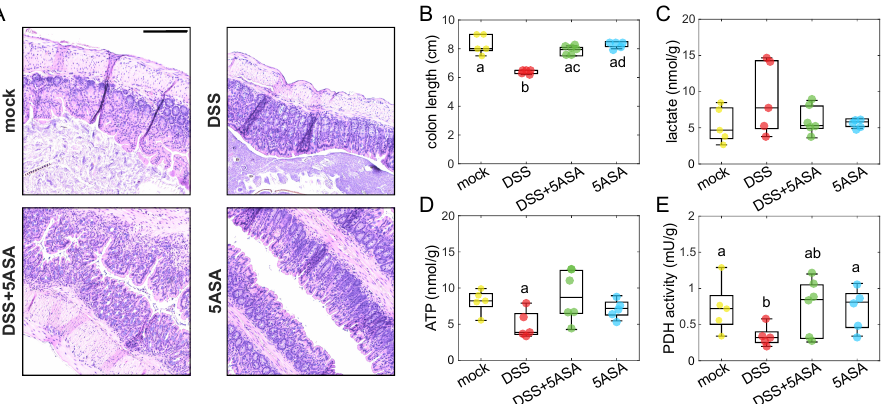
Figure 4. ( A ) Representative H&E images of distal colon sections from each group. Scale bar = 200 µ m. Biochemical measurements on the imaged colons include colon length ( B ), intracellular lactate ( C ), ATP levels ( D ), and PDH activity ( E ). Pairwise Mann–Whitney U test was applied to test statistical differences between